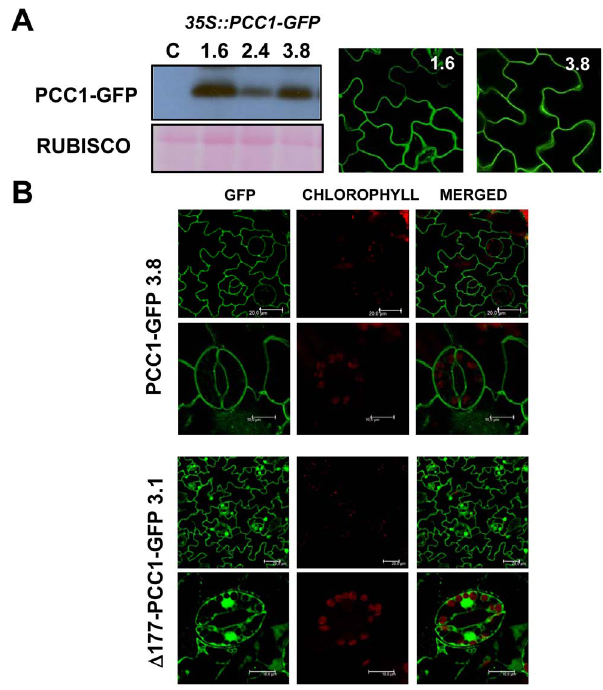
Figure 2. Plasma membrane localization of PCC1 in transgenic 35S::PCC1-GFP Arabidopsis plants. (A) Levels of PCC1-GFP protein in three independent homozygous lines and control C non-transformed plants were analyzed by Western blot with anti-GFP antibodies. PonceauS-stained Rubisco is shown as loading control. Transgenic lines 1.6 and 3.8 with maximal PCC1 expression showed GFP-associated fluorescence by confocal microscopy in the plasma membrane. (B) Membrane-associated localization of PCC1-GFP contrasts with D 177PCC1-GFP that localizes in both the cytoplasm and nucleus. The second row of images for every genotype shows magnification of stomata guard cells.